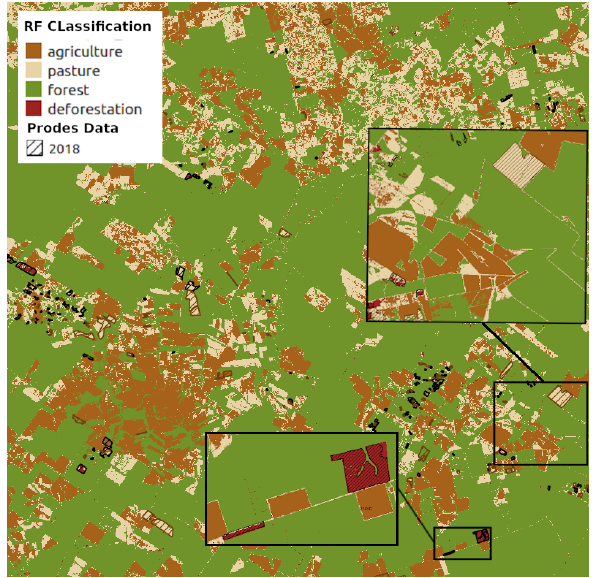
Figure 5. PRODES and RF Classification with index NDVI at tile 21LYH of January 2018 with details.